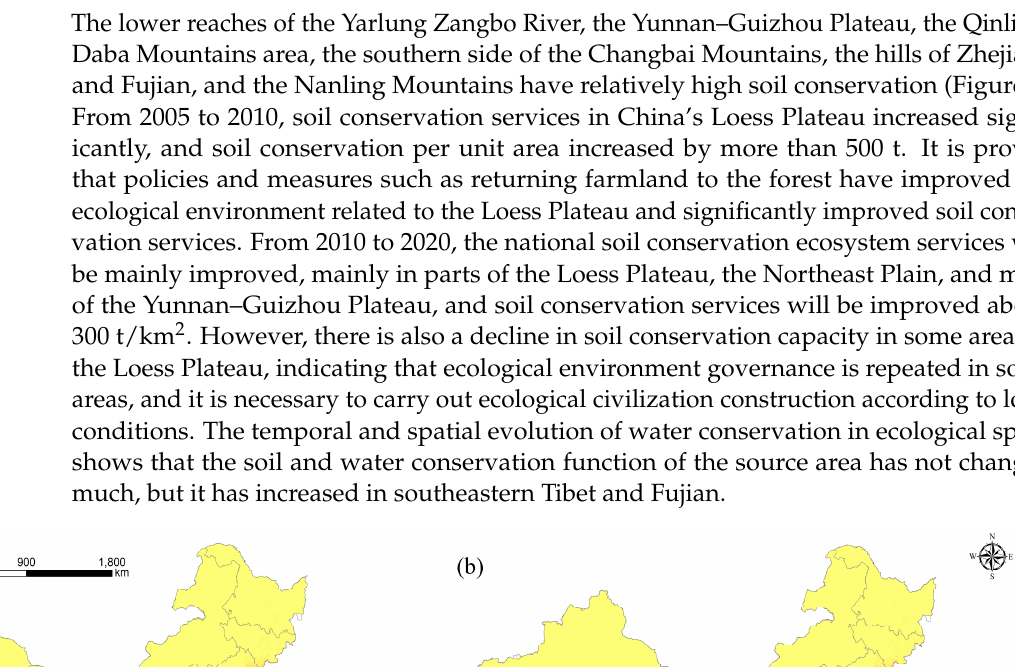
Figure 3. Temporal and spatial evolution of water conservation function in China. ( a ) Water con- servation in 2005 ; ( b ) Water conservation in 2020.